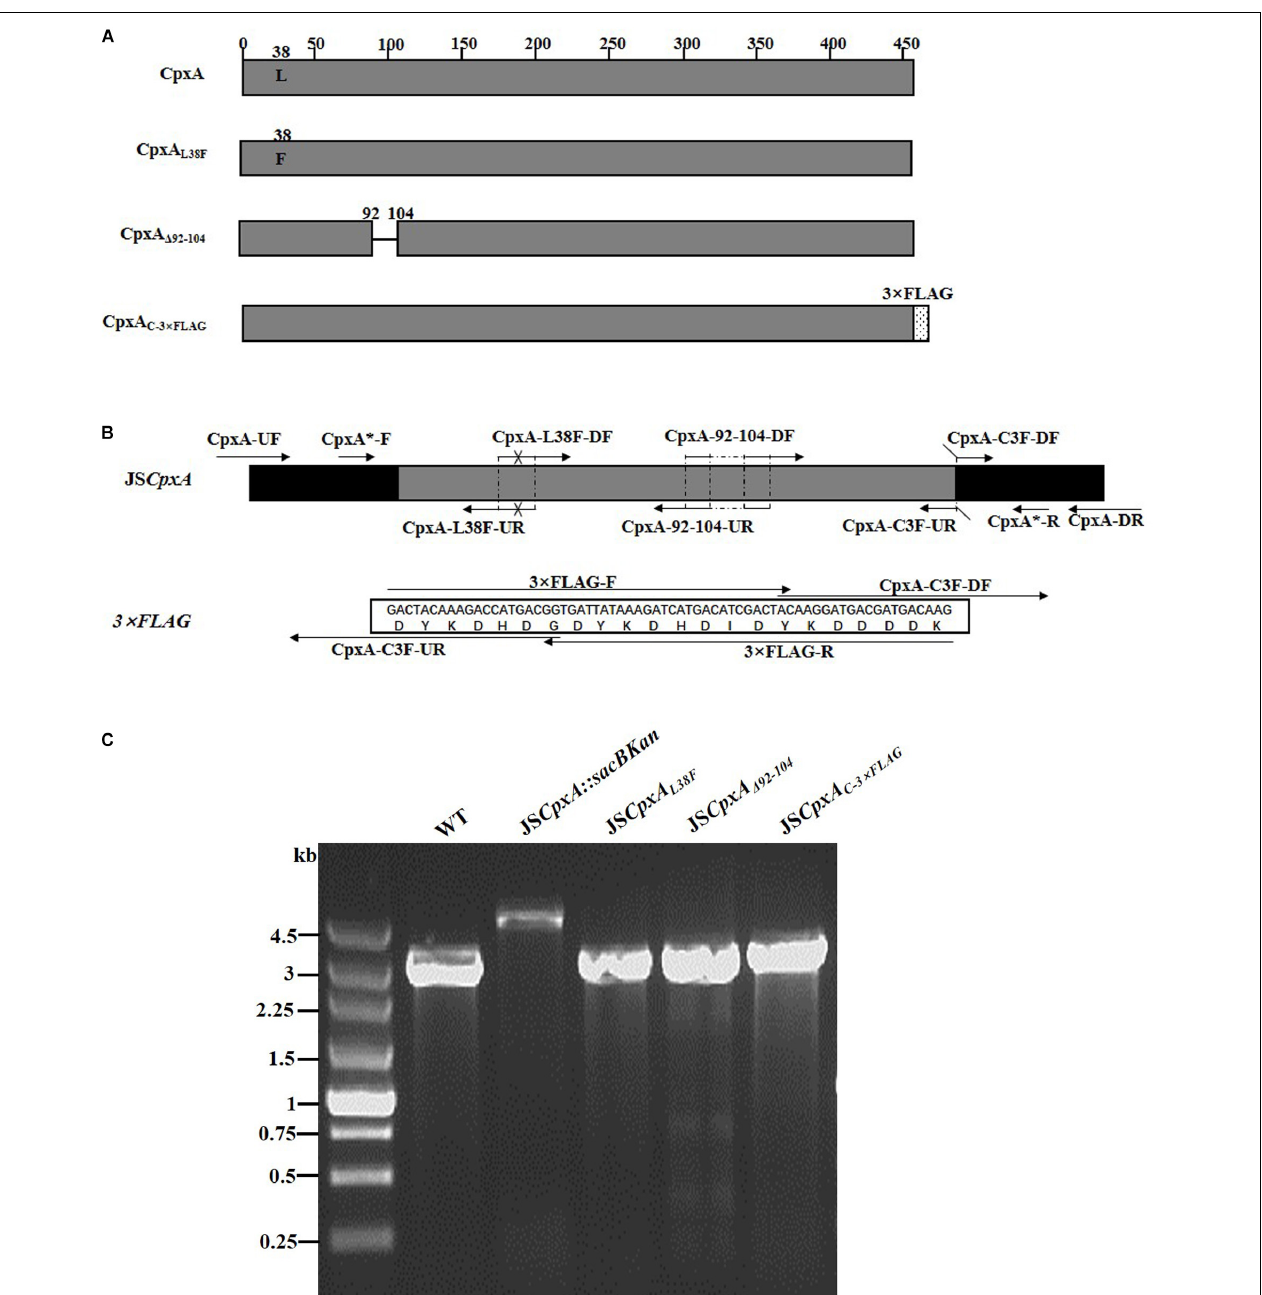
FIGURE 5 | Construction of different gene modifications of cpxA gene. (A) Schematic diagram of the gene structure of different cpxA gene modifications. The JS CpxA L 38 F mutant includes the point mutation at the 38th amino acid (L → F) of the CpxA protein. The JS CpxA (cid:49) 92 − 104 mutant lacks a region including 13 amino acids encoding the periplasmic loop of the CpxA protein. The JS CpxA C − 3 × FLAG strain expresses the C-terminal 3 × FLAG-tagged CpxA protein. (B) Primer design for constructing the mutagenic substitution fragment. The universal primers are CpxA-UF/DR and CpxA-F*/R*, and the mutation primers are CpxA-L38F-DF/UR, CxpA-92-104-DF/UR, and CpxA-C3F-DF/UR. The overlapping region of CpxA-L38F-DF/UR includes the point mutation at codon 38 (CTG → TTT) of the CpxA gene used to create the CpxA L 38 F point mutation fragment. The overlapping region of CpxA-92-104-DF/UR lacks 13 codons (92GGA → 104ATC) used to create the CpxA (cid:49) 92 − 104 deletion mutation fragment. The primers 3 × FLAG-F/R are two complementary oligonucleotides used to create the 3 × FLAG tag fragment. The primers CpxA-C3F-DF and CpxA-C3F-DF both include the overlapping region with the 3 × FLAG tag fragment used to create the C-terminal tagging CpxA fragment. (C) PCR analysis of CpxA multiple mutants. Band sizes: WT, 2.89 kb; intermediate strain (JS CpxA : sacBKan ), 4.76 kb; final strain (JS CpxA L 38 F ), 2.89 kb; final strain (JS CpxA (cid:49) 92 − 104 ), 2.85 kb; final strain (JS CpxA C − 3 × FLAG ), 2.95 kb. Molecular size markers (250 bp DNA ladder marker, Takara) are indicated. WT, wild